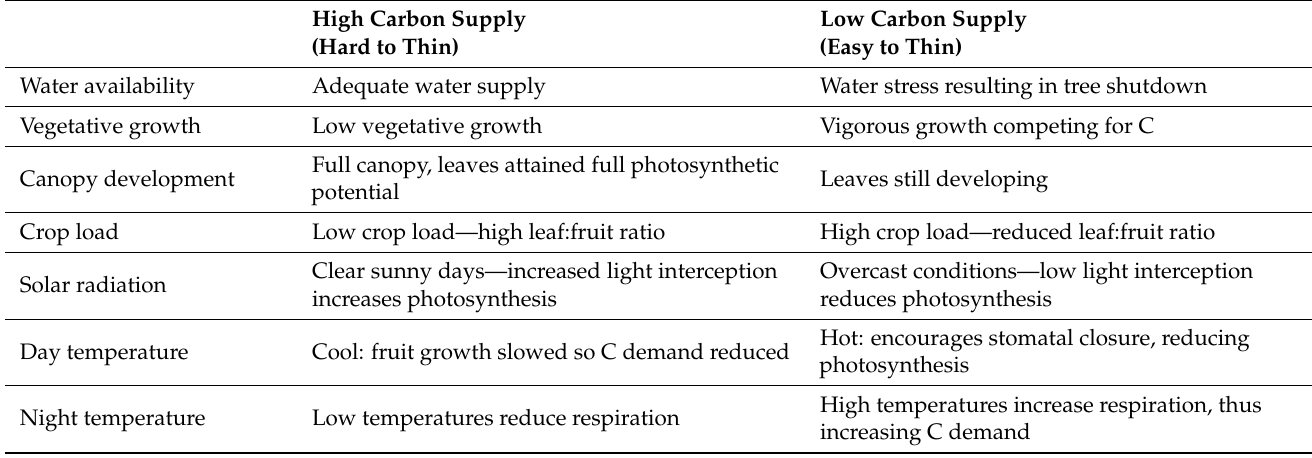
Table 2. Factors affecting tree carbon balance during fruit